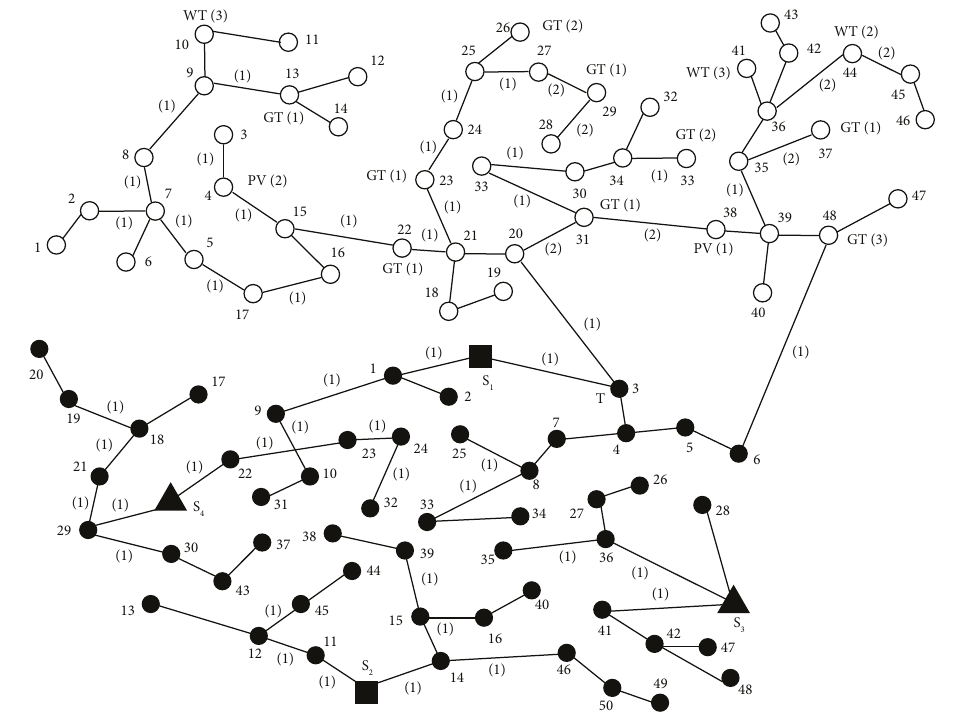
Figure 9: Configuration of the network in case #3. Table 10: The obtained results for the case